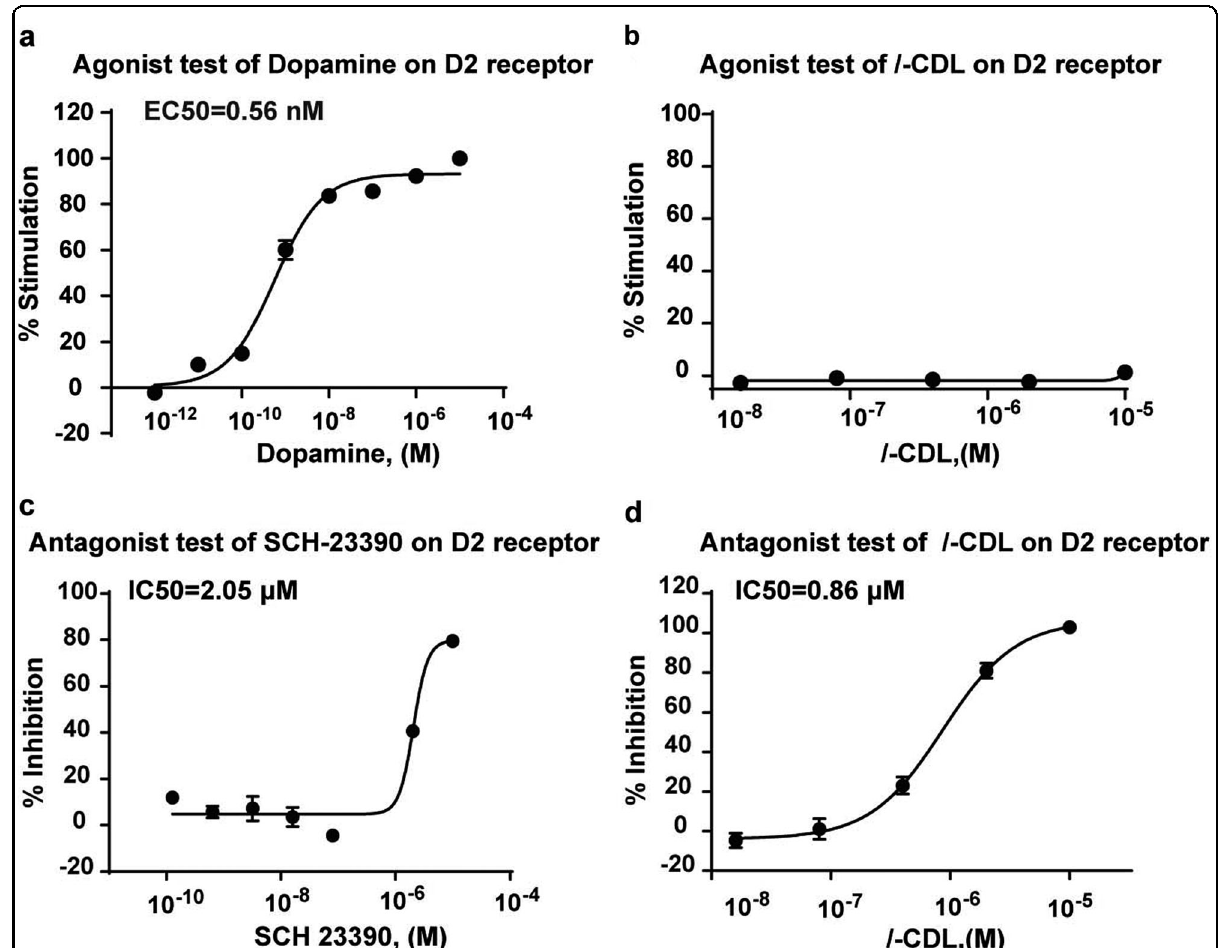
did not activate D2DR to induce Ca 2 + mobilization in D2/CHO-K1 cells. c The D2DR antagonist SCH-23390 inhibited dopamine-induced Ca 2 +